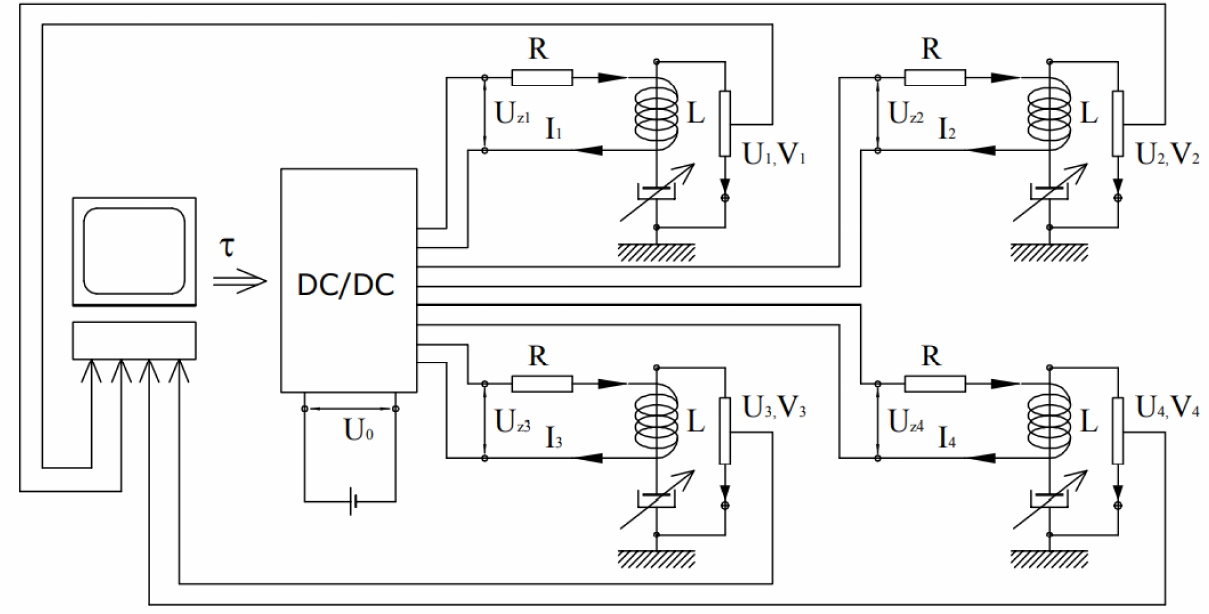
Figure 12. Scheme of the supply system: τ —control signal (vector of damping parameter); U 0 —battery voltage; U z1 , U z2 , U z3 , U z4 —coil supply voltage; I 1 , I 2 , I 3 , I 4 —coil current; R—resistance; L—coil inductance; U 1 , U 2 , U 3 , U 4 —displacement of the dampers; V 1 , V 2 , V 3 , V 4 —velocity of the